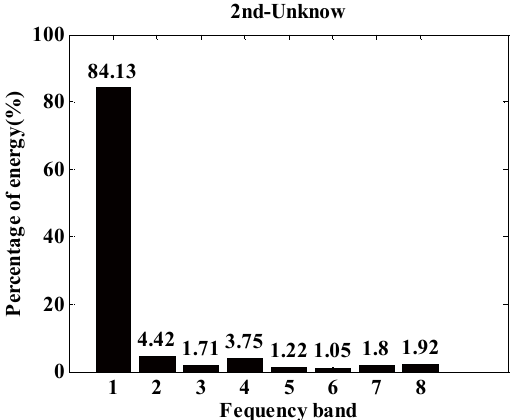
Figure 9. The first transformer vibration signal FBE Histogram. Mathematics 2019, 7, x FOR PEER REVIEW